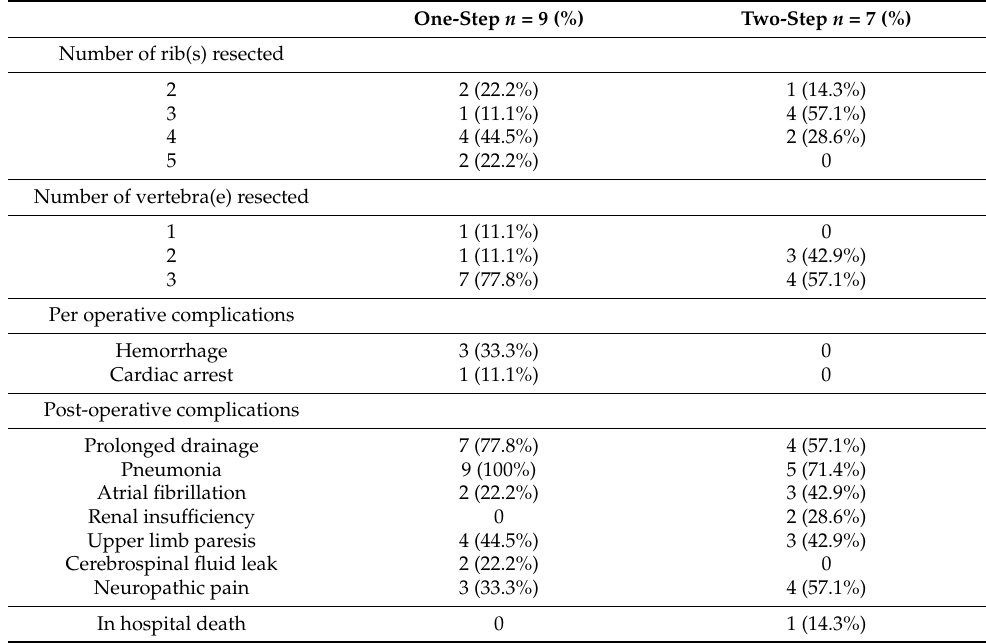
Table 2. Surgical characteristics and